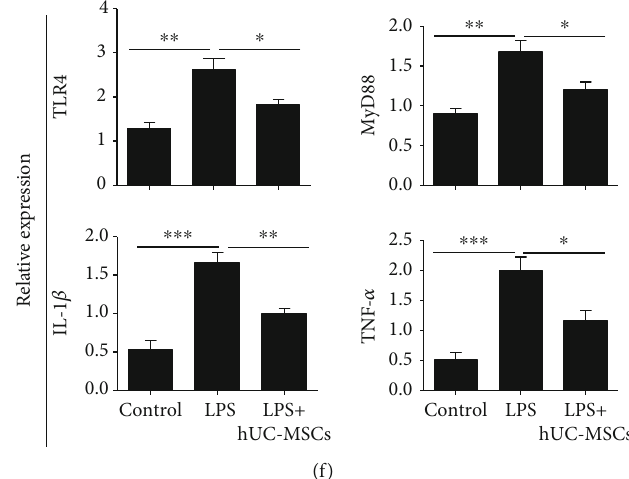
Figure 8: hUC-MSCs modulate TLR4 pathway-related agents and proin fl ammatory mediator levels in LPS-treated BV2 cells. (a and b) Double staining for iba-1 (green) and TLR4 (red), showing poor colocalization of iba1 and TLR4. The fl uorescence intensity showing reduced expression of iba-1 and TLR4 in LPS-treated BV2 cells after hUC-MSC treatment ( n = 4/group ; ∗ P < 0 : 05 and ∗∗∗ P < 0 : 001 compared with one-way ANOVA with Turkey ’ s post hoc tests). (c and d) Double staining for CD16 (green) and TLR4 (red) showing colocalization of CD16 and TLR4. The fl uorescence intensity showing reduced expression of CD16 and TLR4 in LPS-treated BV2 cells after hUC-MSC treatment ( n = 4/group ; ∗ P < 0 : 05 , ∗∗ P < 0 : 01 , and ∗∗∗ P < 0 : 001 compared with one-way ANOVA with Turkey ’ s post hoc tests). (e and f) Quanti fi cation of TLR4, MyD88, IL-1 β , and TNF- α expression by western blot analysis showing a signi fi cant decrease in TLR4, MyD88, IL-1 β , and TNF- α expression after hUC-MSC treatment ( n = 4/group ; ∗ P < 0 : 05 , ∗∗ P < 0 : 01 , and ∗∗∗ P < 0 : 001 compared with one-way ANOVA with Turkey ’ s post hoc tests). Scale bar: 50 μ m.